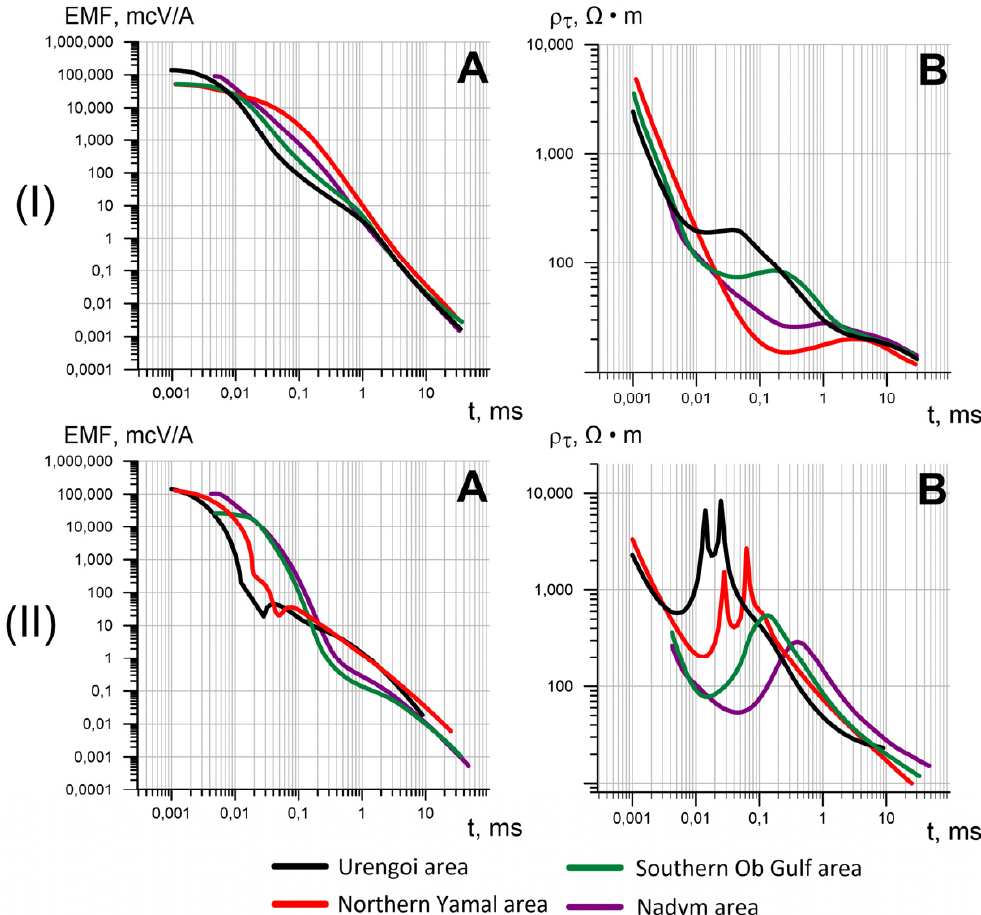
Figure 9. sTEM responses recorded with central–loop arrays, not affected ( I ) and affected ( II ) by